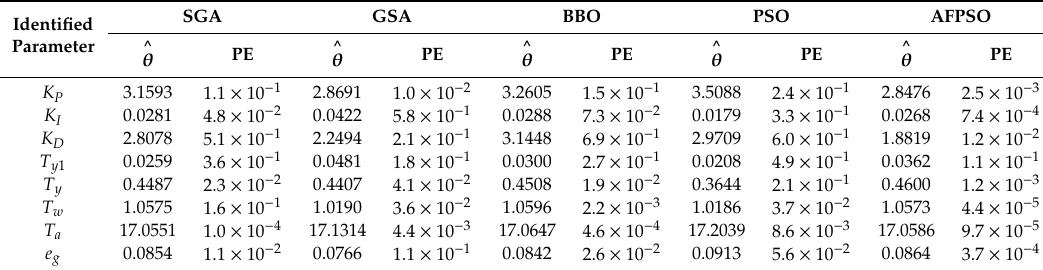
Table 4. Average estimated value and parameter error obtained by di ff erent algorithms in 30 tests (no-load condition).